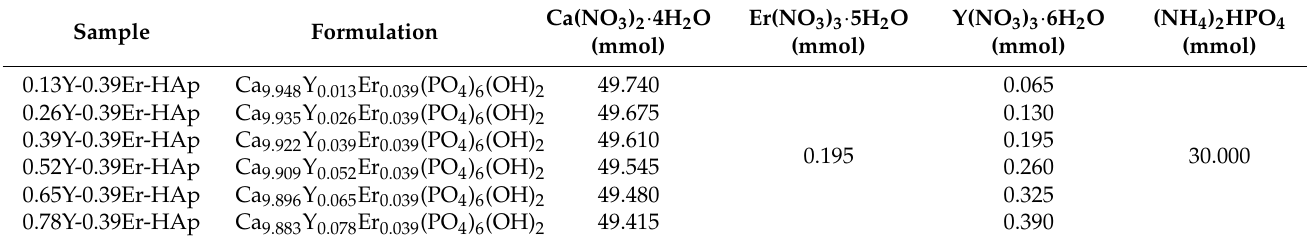
Table 1. The amount of each chemical used in the